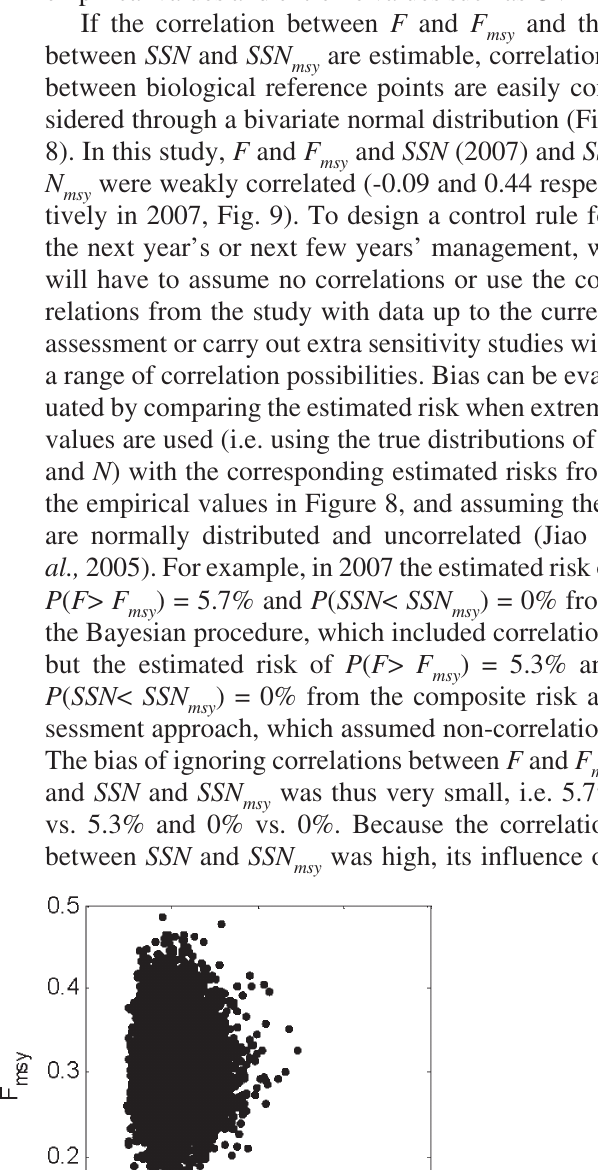
, and SSN and SSN msy